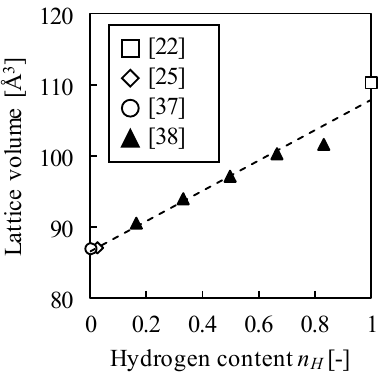
Figure A1. Dependence of lattice volume on hydrogen content.